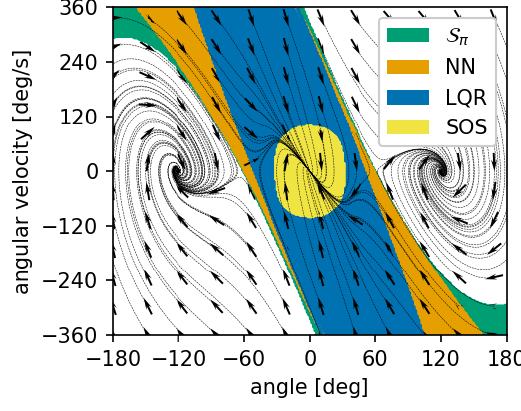
Fig. 4. Results for training the Lyapunov NN candidate 𝑣 𝜃 for an inverted pendulum. System trajectories (black) converge to the origin only within the largest safe region 𝑆 𝜋 (green). The NN candidate (orange) characterizes 𝑆 𝜋 with a level set better than both the LQR (blue ellipsoid) and SOS (yellow) candidates, as it adapts to the shape of 𝑆 𝜋